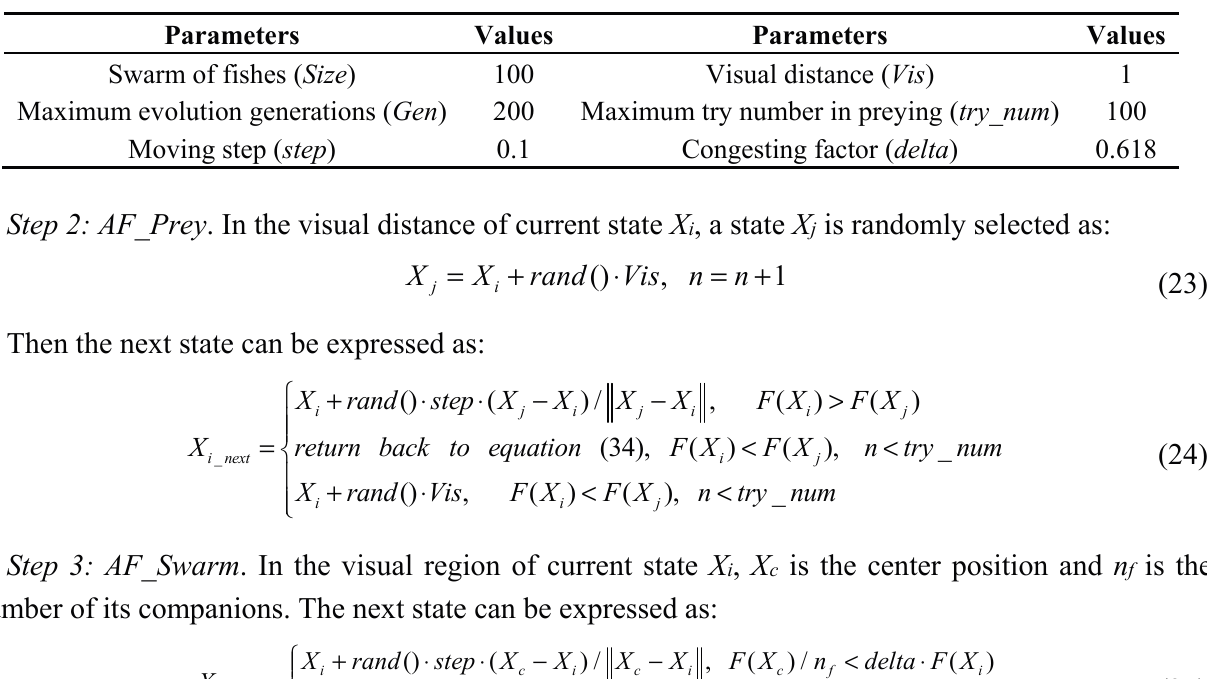
Table 4. Parameters of